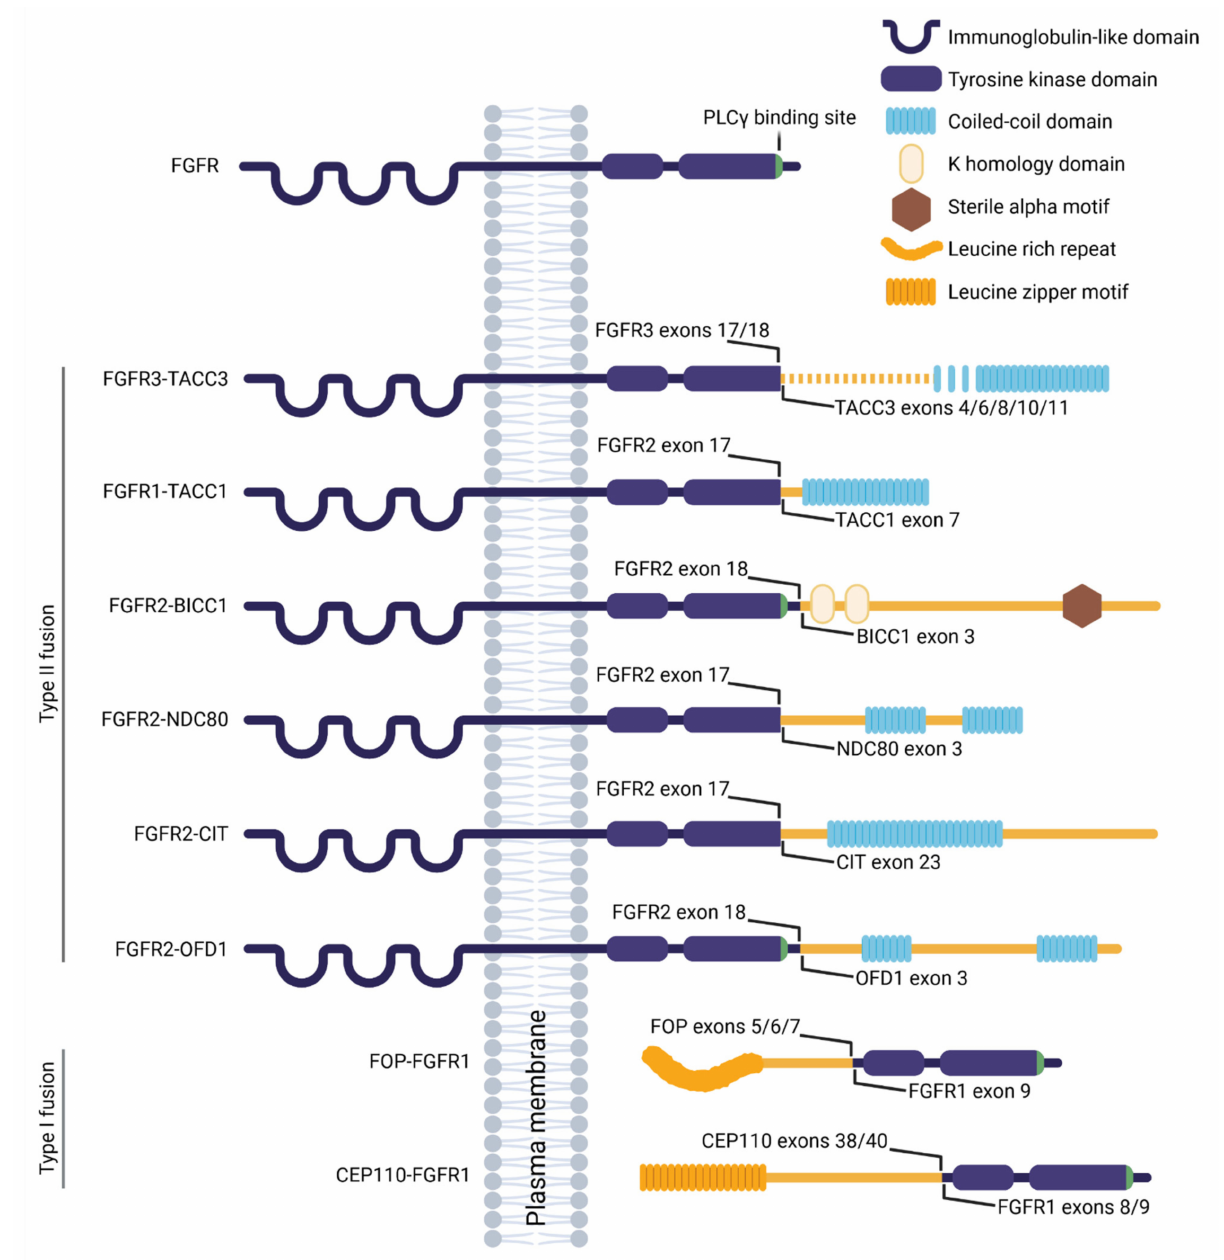
Figure 1. Schematic representation of the FGFR fusion proteins. The wild-type FGFR comprises the extracellular immunoglobulin-like domain, responsible for ligand binding, the transmembrane region, and the intracellular part that is responsible for binding and activation of the signal transducers including PLC γ (binding site indicated in green). The type II fusions lose a variable part of the C-terminal region of FGFR, frequently involving the PLC γ binding site, and attach a truncated C-terminal part of the fusion partner. In type I fusions, the FGFR extracellular and transmembrane parts are excluded, and the truncated fusion partner joins in just before the FGFR kinase domain. In both types of FGFR fusion, the partner possesses domains that facilitate dimerization—the coiled-coil domain, the sterile alpha motif, the leucine rich repeat or the leucine zipper. The positions of the fusion breakpoints are